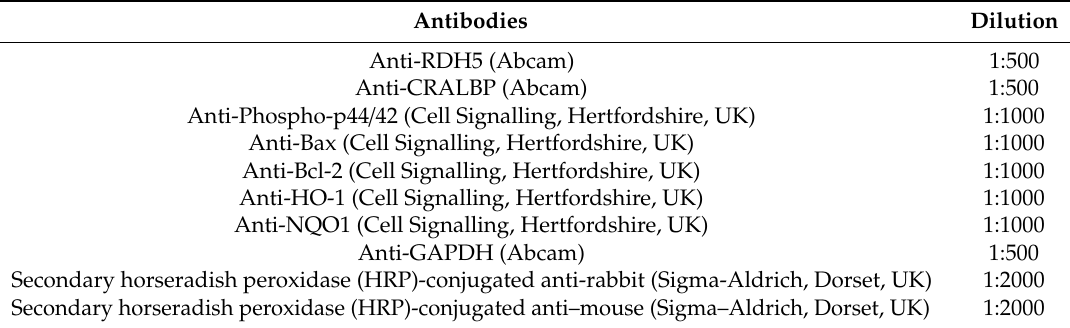
Table 1. Antibodies used for the analysis of protein